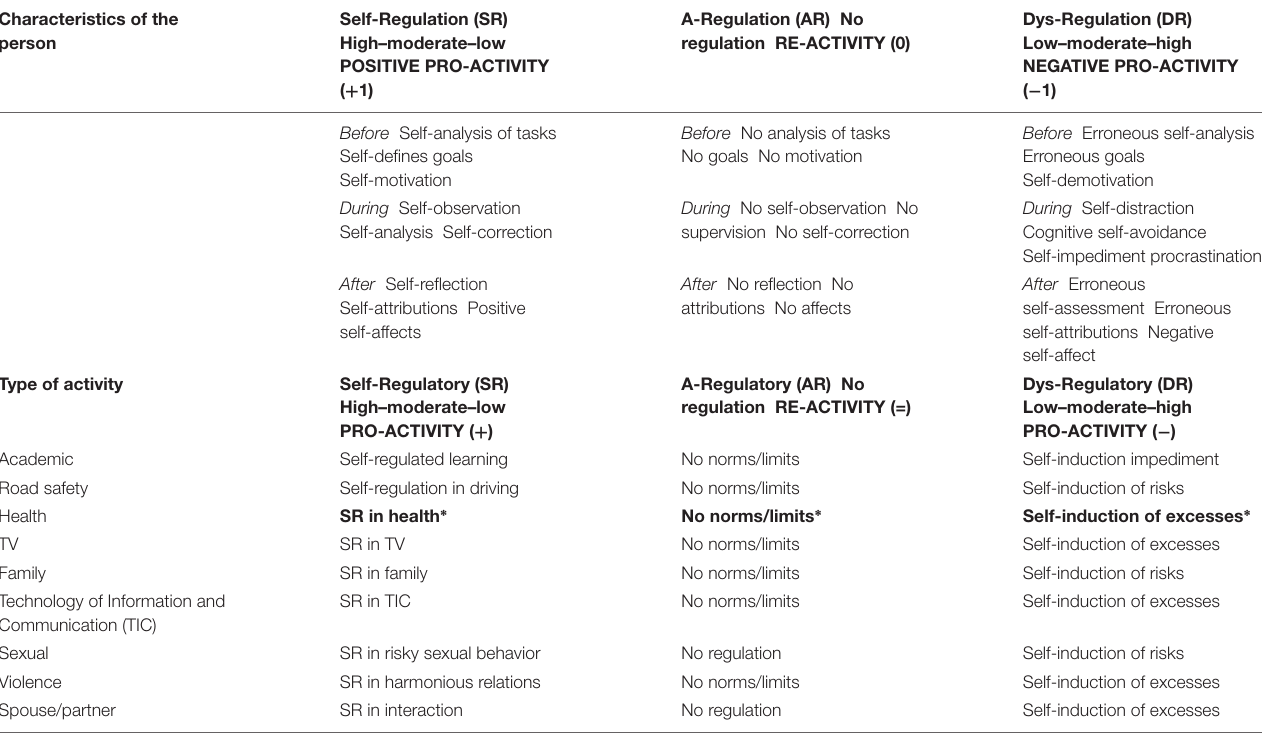
TABLE 1 | Conceptual continuum and typologies of each Self-Regulatory Behavior (reproduced with permission). Characteristics of the